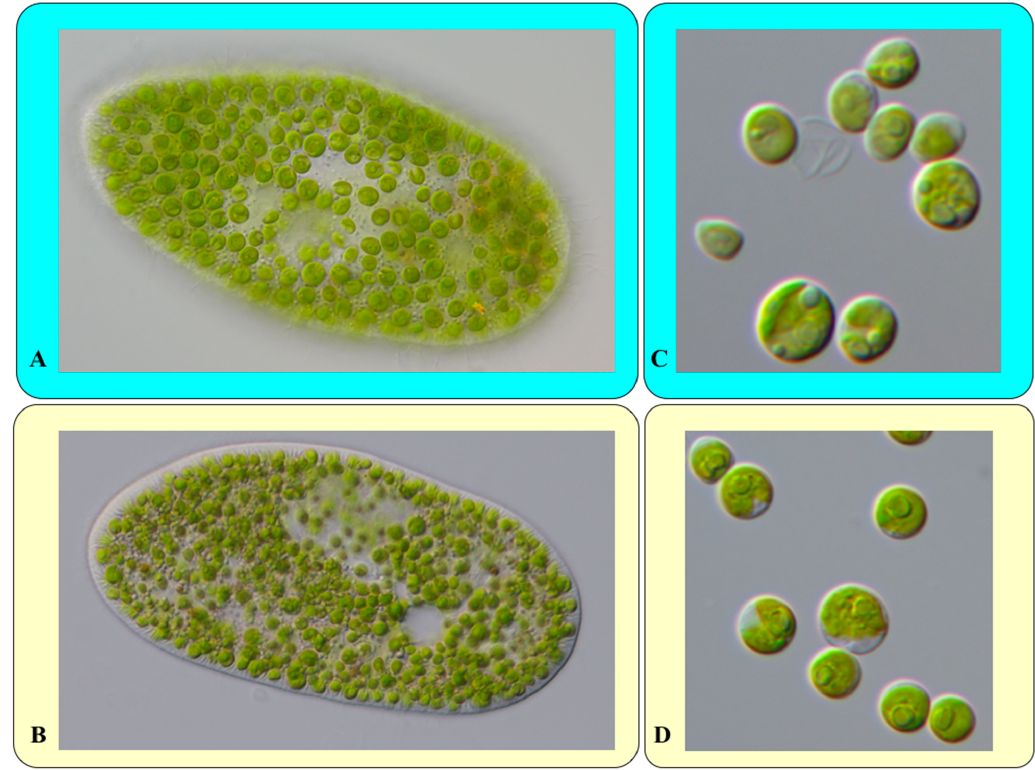
Figure 1. Morphology of Chlorella variabilis and Micractinium conductrix in their host Paramecium bursaria strains and cultivated as axenic strains. ( A,B ) Paramecium bursaria strains CIL-16 ( A ) and SAG 27.96 ( B ), respectively, ( C ) CCAP 211/84 = NC64A; ( D ) SAG 241.80.